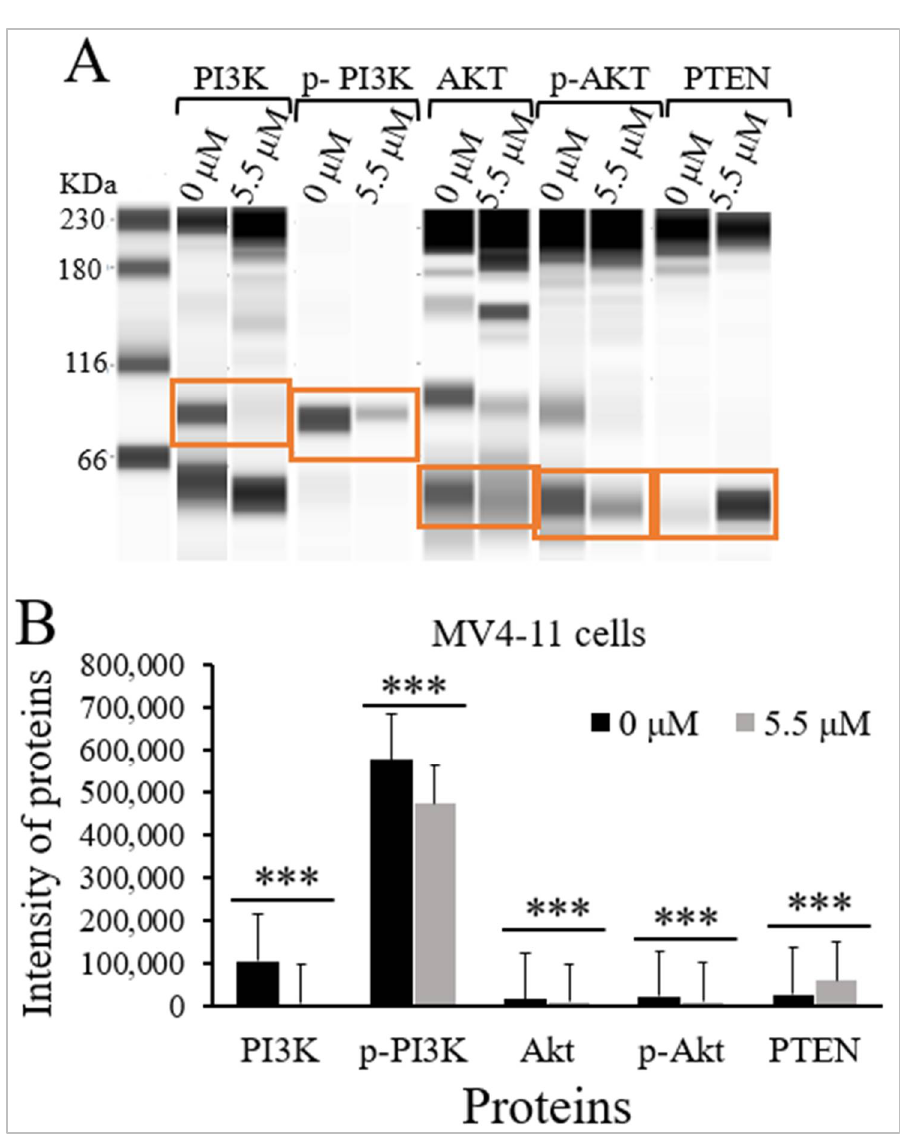
Figure 4. Effect of TQ on the activation of PI3K/Akt/mTOR signaling in MV4-11 cells. The cells were incubated for 48 h with 5.5 μM TQ. The protein levels were determined by Jess simple western analysis. ( A ) Images of Jess simple western analysis for the target proteins before and after TQ treatment. ( B ) The bar graph demonstrates the reduction of PI3K, p-PI3K, Akt, and p-Akt, and the increase of PTEN protein levels in MV4-11 cells after TQ treatment. Wilcoxon signed rank test was applied, and the results are stated as medians and interquartile range (error bars) (n = 3), *** p < 0.001 is significant versus untreated control cells.